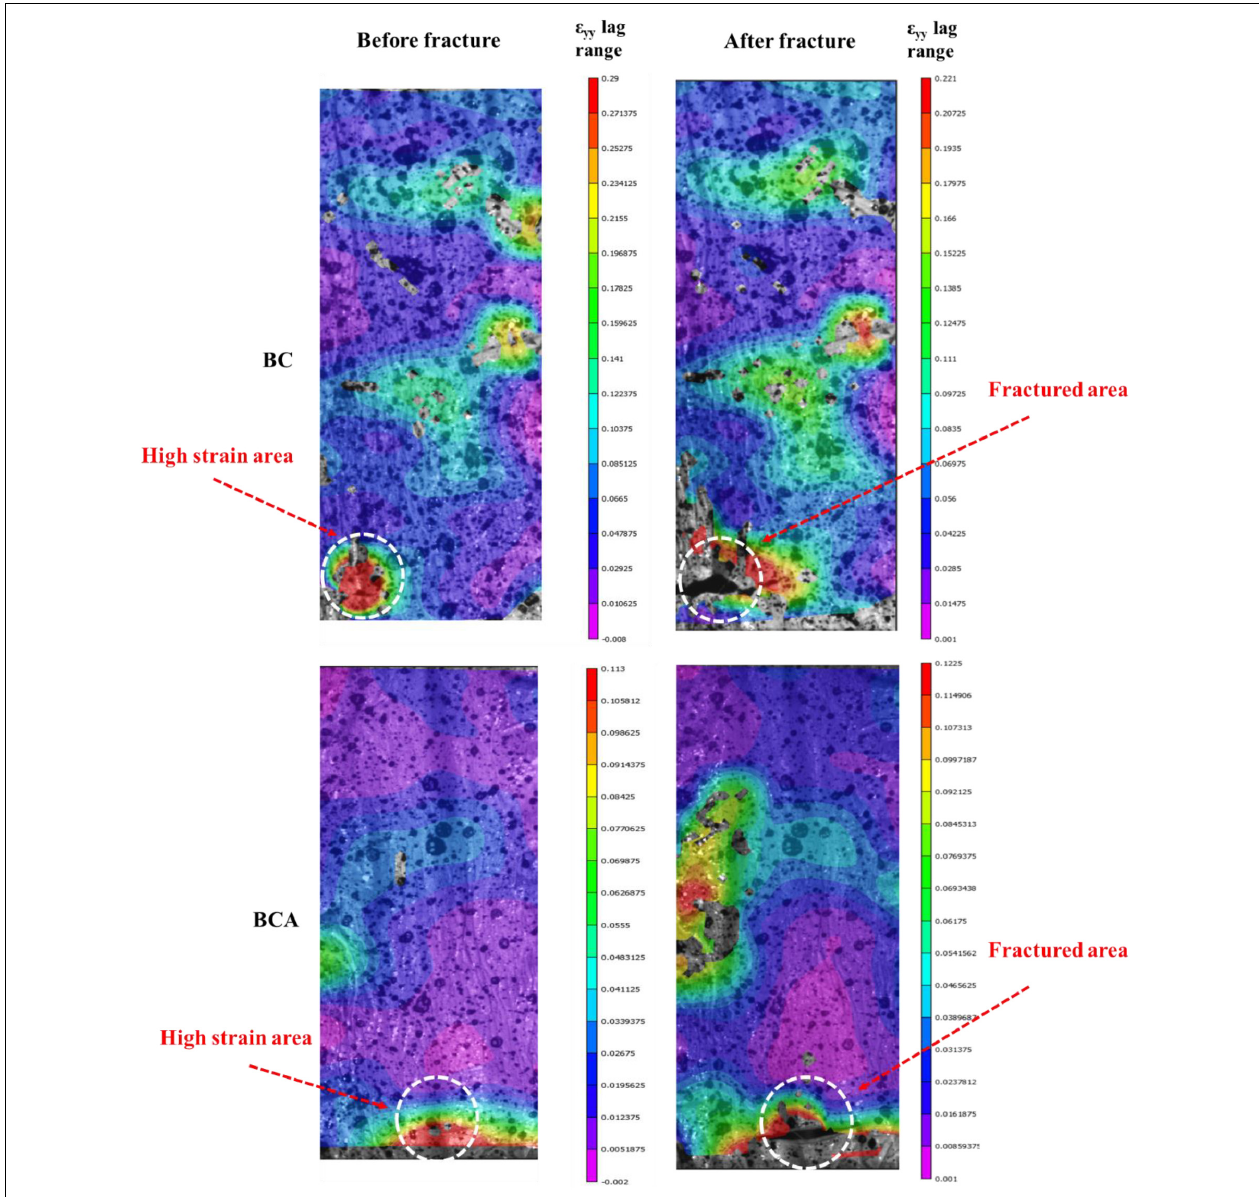
FIGURE 5 | Mechanical behavior of pristine BC and ex situ developed Aloe vera -loaded-BC composite (i.e., BCA) determined through the 3D-DIC system. The deformation of samples was determined before and after a fracture. The arrows indicate the high strain and fractured areas in both pristine BC and BCA composite.